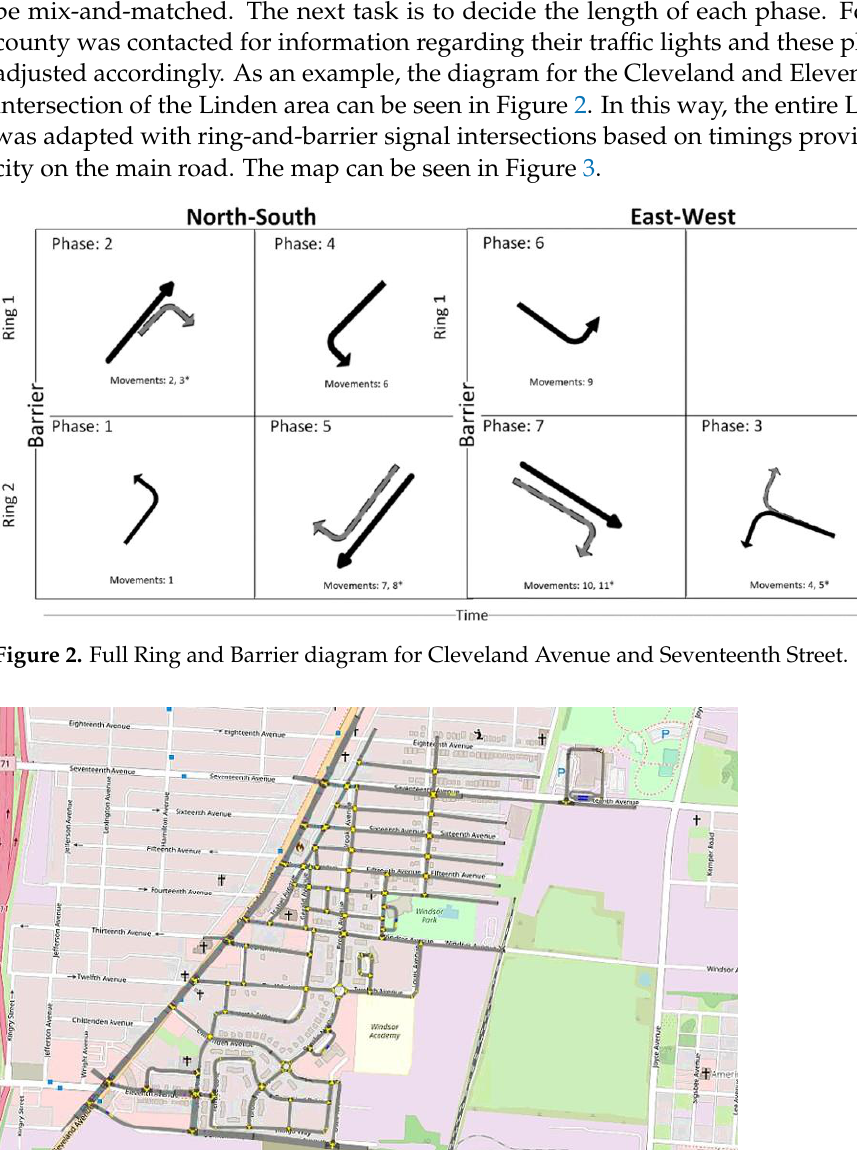
Figure 4. Plot of percentage vehicles vs. time of day.